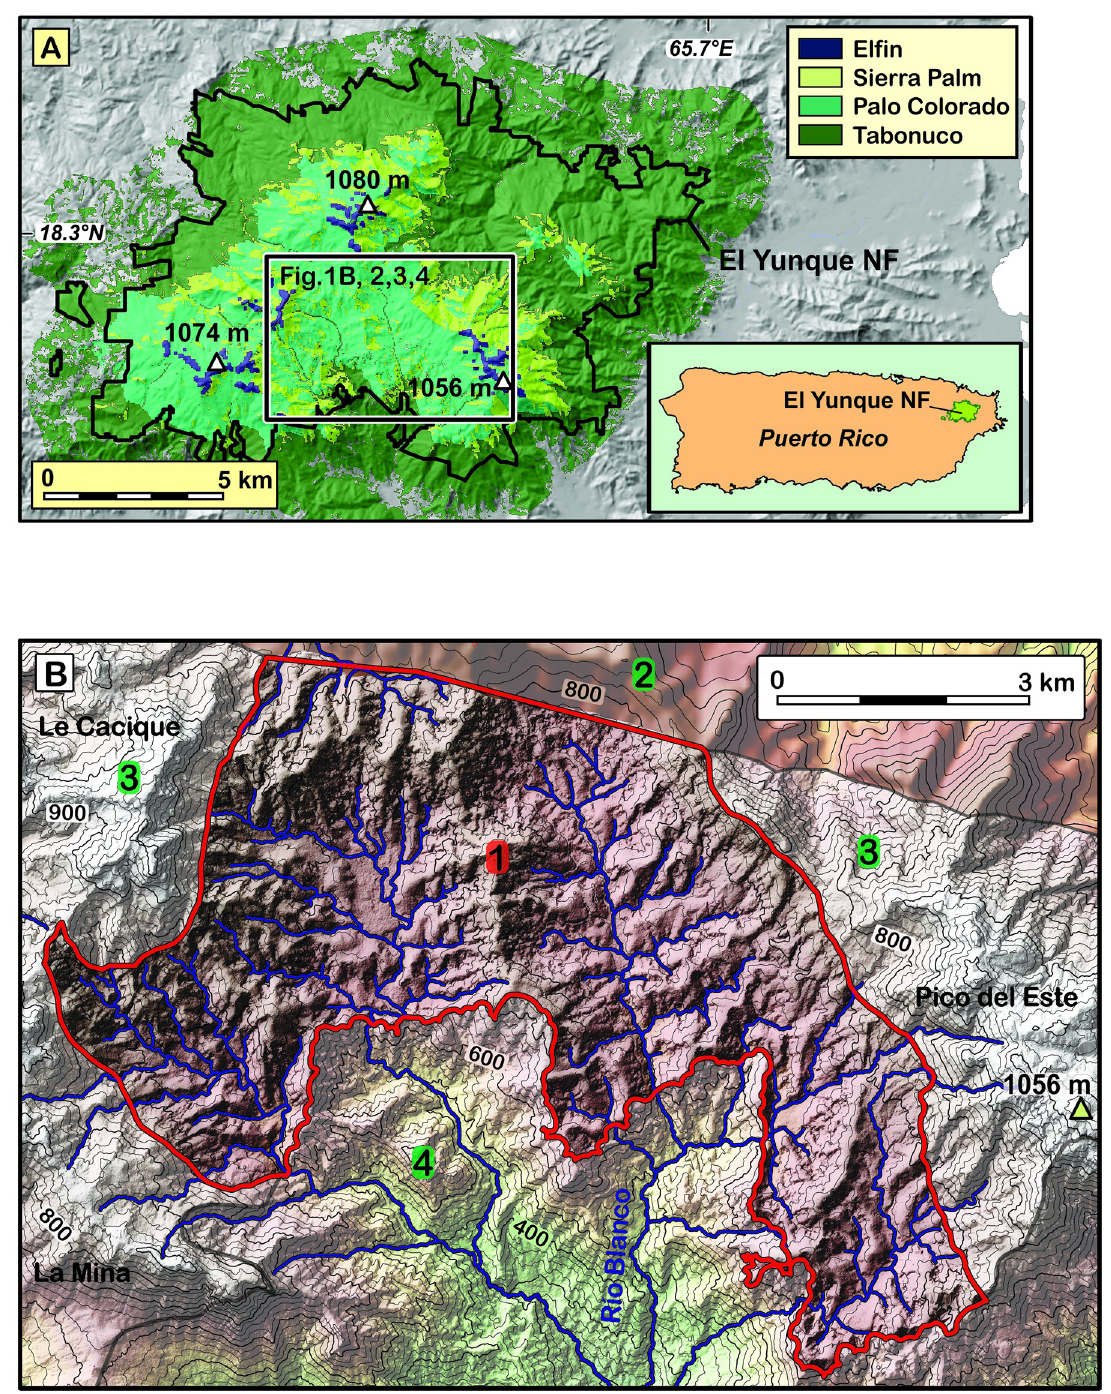
Fig 1. Geographic setting of the study area. A: Map showing the altitudinal zoning of vegetation that characterizes the El Yunque National Forest, over a shaded relief of the Luquillo Mountains. Black outline: border of El Yunque National Forest. Inset: Location of the forest on Puerto Rico island. Vegetation data from (Gould et al., 2008) [14]. Tabonuco Forest: tall lower montane rainforest, Sierra Palm Forest and Palo Colorado Forest: monocot and dicot-dominated montane rainforests, Elfin: dwarfed forest on mountain tops. B: topographic map showing the limits (red line) of the studied area (1). The extent of the study area was determined by exclusion of areas lacking either LiDAR coverage (2) or the quartz necessary for 10 Be-based quantification of erosion rates (3), and by exclusion of areas affected by accelerated erosion